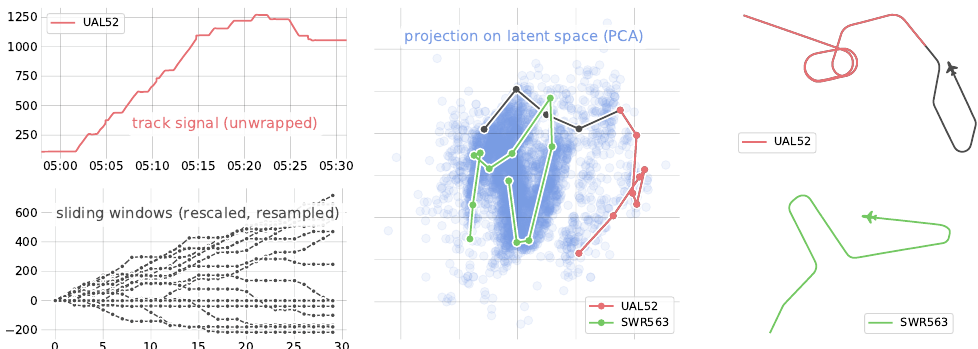
Figure 9. The 19,480 trajectories are split into sliding windows, rescaled and resampled (30 samples per window). The resulting 72,353 samples are then projected with a PCA. Holding patterns cluster in the latent space: the red part of the trajectory is well identified as a holding pattern, whereas the green trajectory, in spite of a pattern easily mistaken with rule-based models, stays in the regular